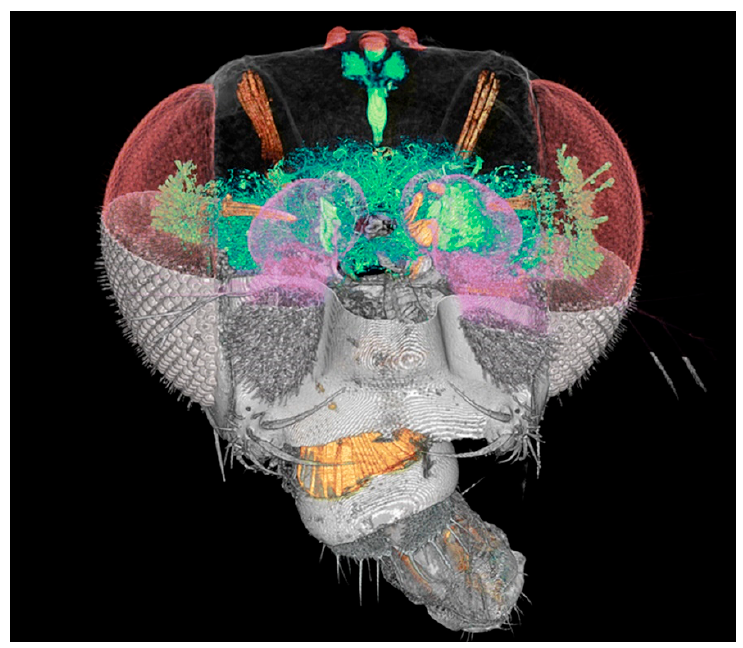
Figure 27. Coherence-based tomographic reconstruction of a drosophila fly head [36,37].